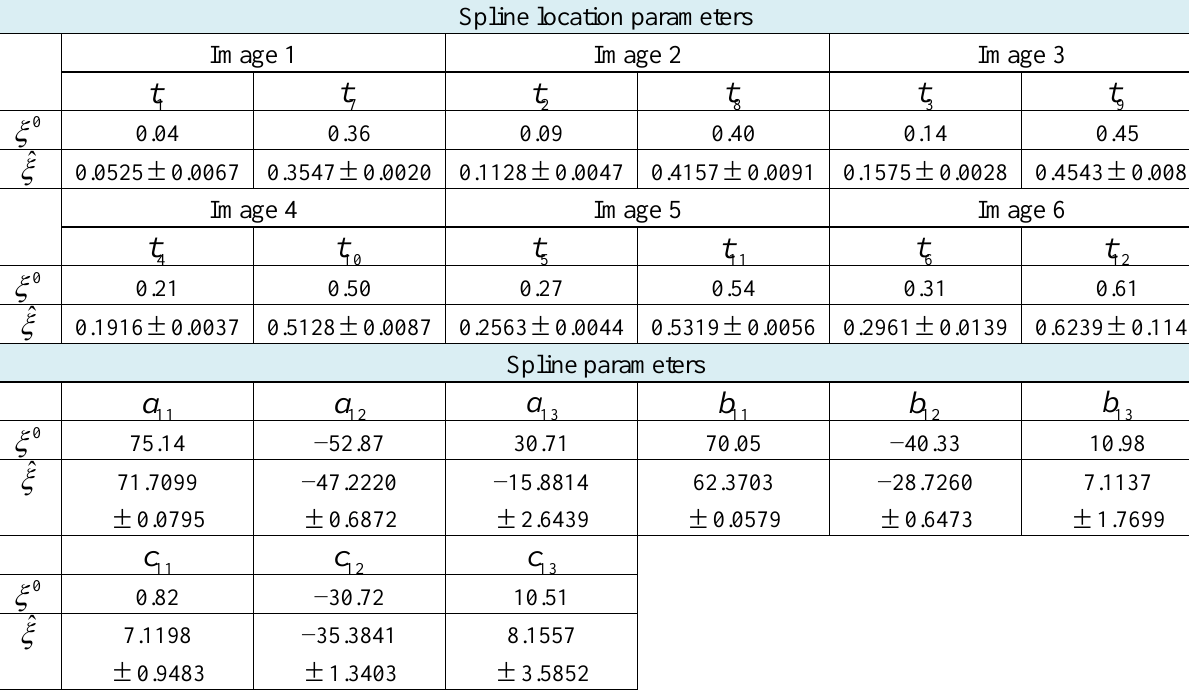
Table 4. Partial spline parameter and spline location parameter recovery.